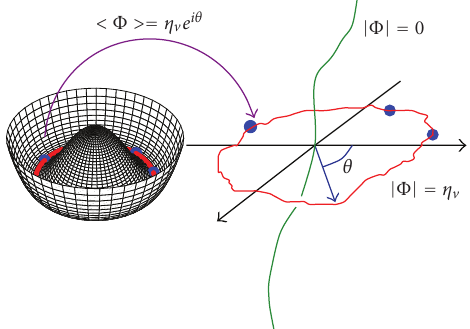
Figure 1: The Abelian Higgs potential in the complex plane [ R ( Φ ), I ( Φ )]. The nontrivial phase mapping from the internal space to the physical space (right) leads to the formation of a cosmic string. The old vacuum | Φ | = 0 becomes trapped inside the new one | Φ | = η v